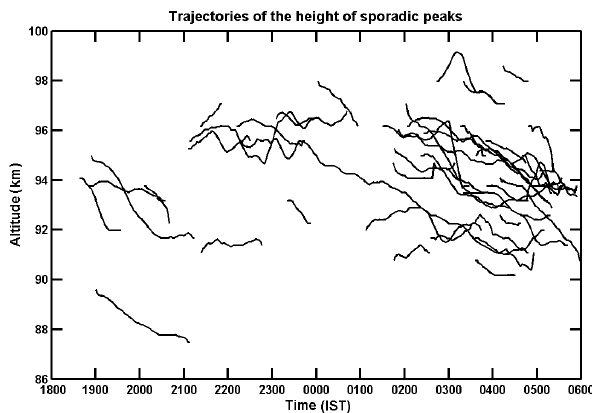
Fig. 8. Histogram of the time of occurrence of SSL events